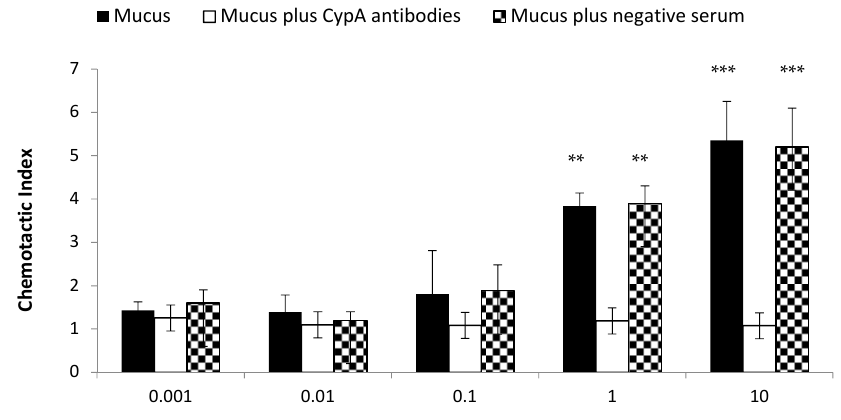
Figure 2. Comparative chemotactic activity of various concentrations of yellow catfish skin mucus. The black bar shows the chemotactic activity of various concentrations of yellow catfish skin mucus for head kidney leucocytes of yellow catfish. The white bar shows the chemotactic activity of the skin mucus when the CypA was blocked by CypA-specific antibodies. The doted bar indicates the chemotactic activity of skin mucus plus serum (negative control). The chemotactic activity is shown as the chemotactic index. Data are expressed as the means ± SD, ( n = 3) of three fish. Bars with “**” are highly significantly different ( p < 0.01), while bars with “***” are very highly significantly different ( p < 0.001).